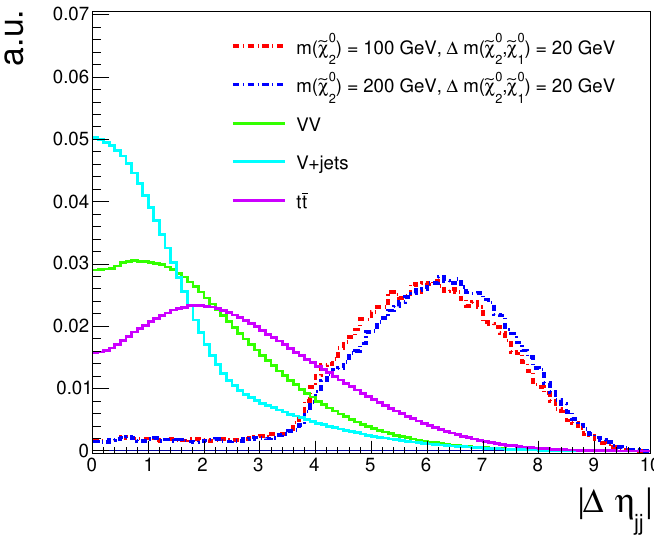
Figure 4 . | ∆ η jj | distribution for dijet candidates containing jets with p T > 30 GeV, for two benchmark signal points and major